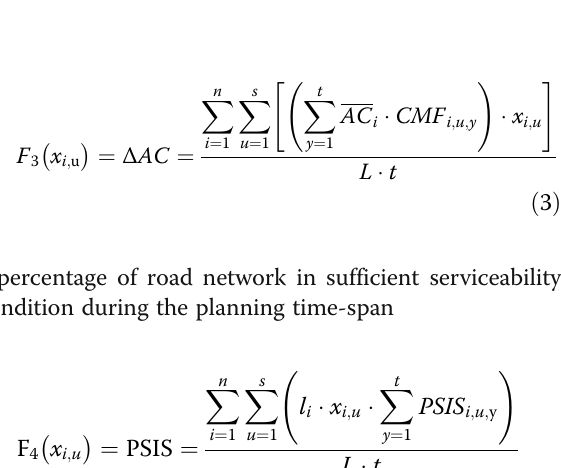
Fig. 2 Decision trees of maintenance strategies (NP=Number of standard sized potholes of area 0.1 m2, PCI = Pavement Condition Index scale 0 – 100, IRI = International Roughness Index scale 0 – 100, R = mean rut depth, CA = Cracking